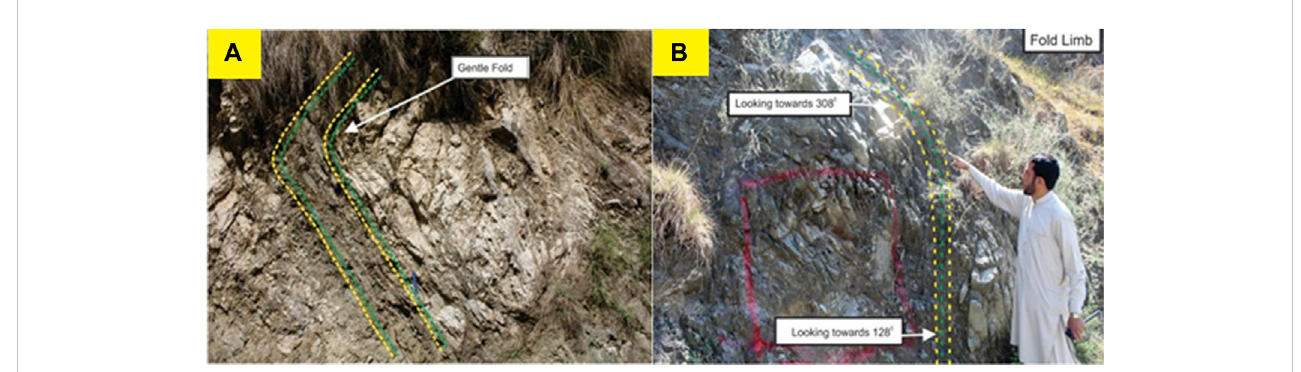
FIGURE 7 (A) Outcrop showing gentle fold with strike 031 and a dip angle of 54 and (B) fold limb.